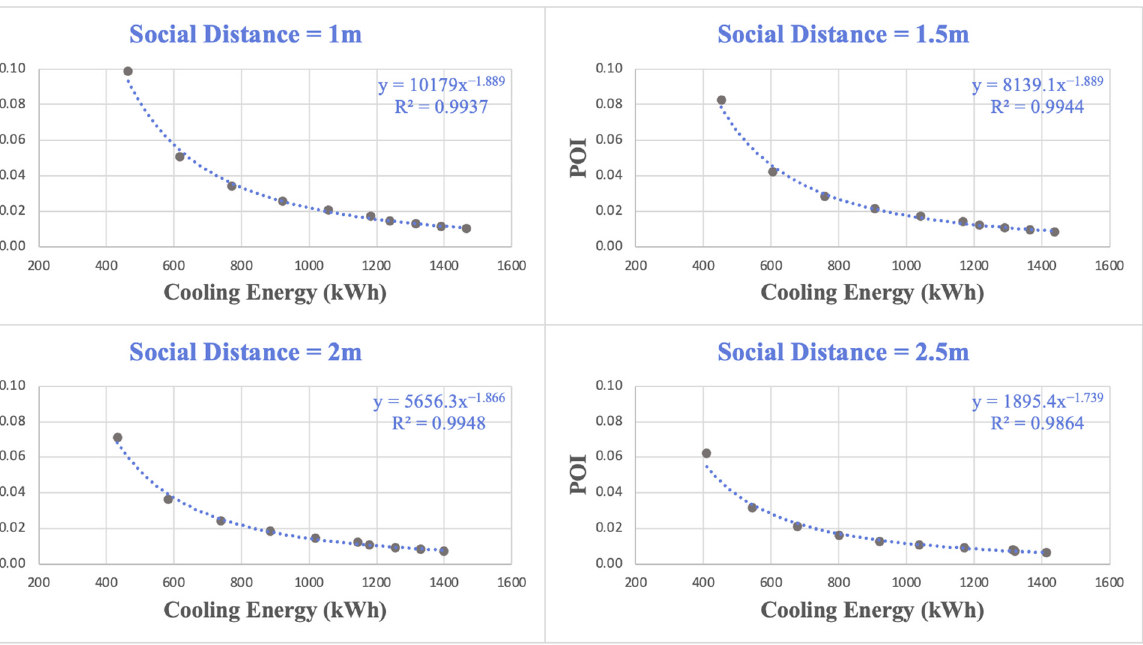
Figure 14. Correlations between POI and cooling energy for a range of ventilation rates and social distances using one infector case for MV system. distances using one infector case for MV